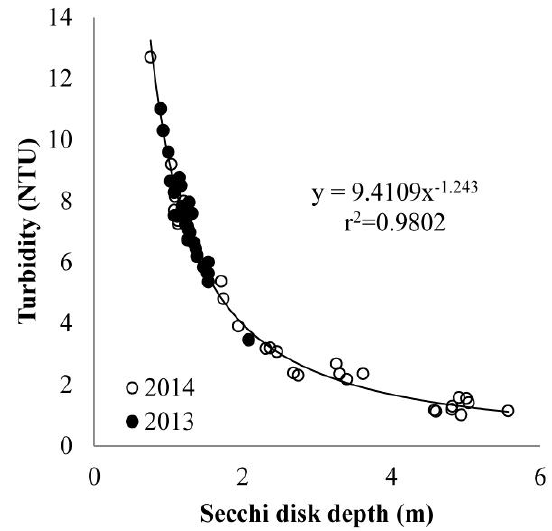
Figure 2. A strong correlation exists between Secchi disk transparency (SDT) measurements and simultaneous measurements from a calibrated nephelometer (NTU M ). This relation is specific to Lake Clark and allows for historical SDT measurements to be converted into standard Nephelometric Turbidity Units (NTU C